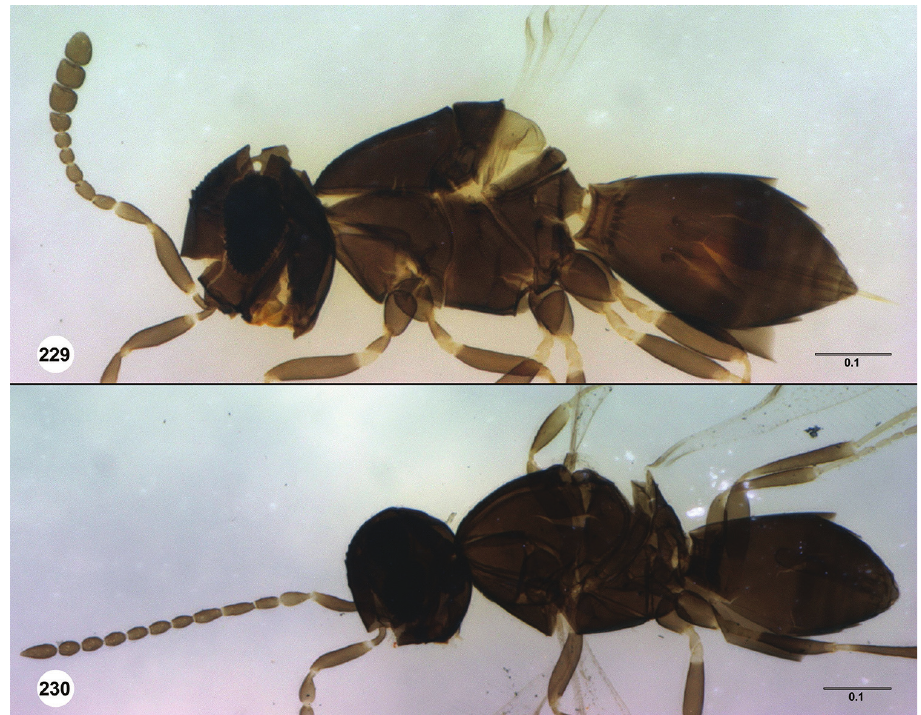
Figures 229–230. Telenomus fulmeki 229 female lectotype (SDEI 0001A), head, mesosoma, metasoma, lateral view 230 male paralectotype (SDEI 0001B), head, mesosoma, metasoma, lateral view. Scale bars in